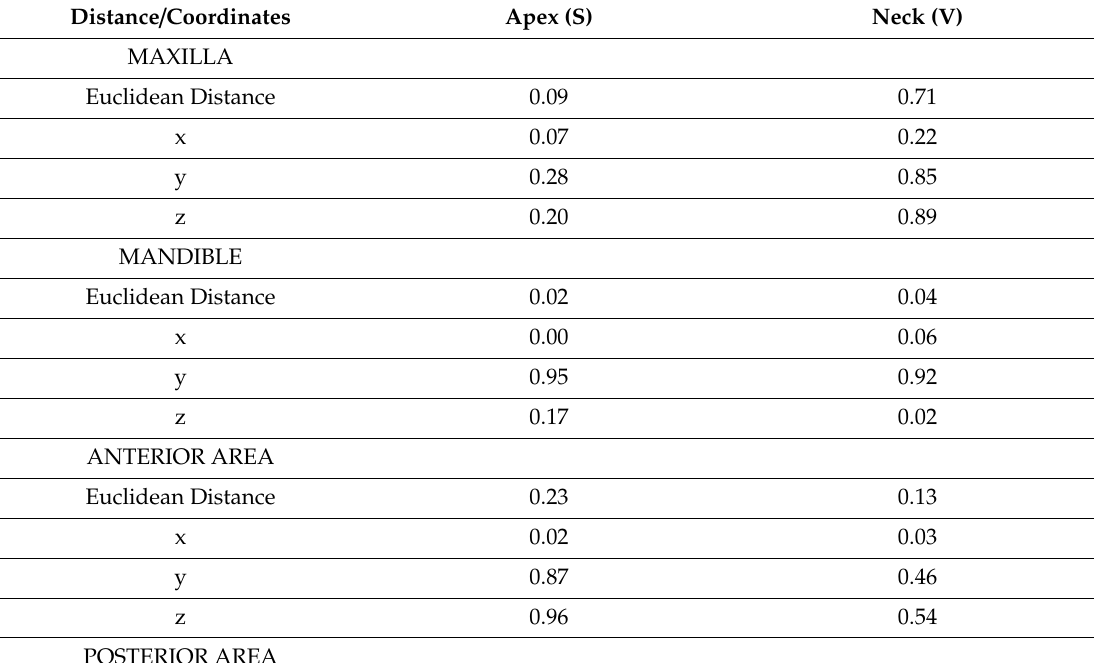
Table 4. Statistical 3D evaluation of discrepancies using multivariate permutation tests in maxillae vs mandibles and anterior vs posterior areas using clinical and virtual apex (S) and neck (V) implant